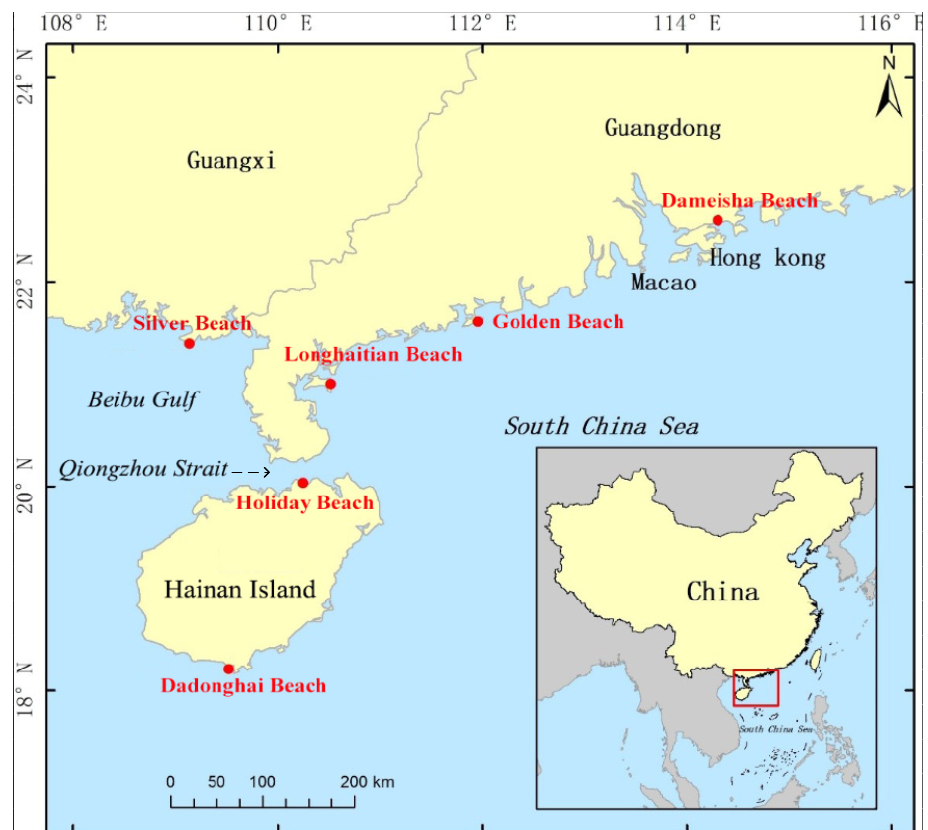
Figure 1. Location of the six beaches on the map of China. They are all famous tourist attractions in South China, namely, Silver Beach in Beihai City, Longhaitian Beach in Zhanjiang City, Hailing Island Gold Beach in Yangjiang City, Dameisha Beach in Shenzhen City, Holiday Beach in Haikou City, and Dadonghai Beach in Sanya